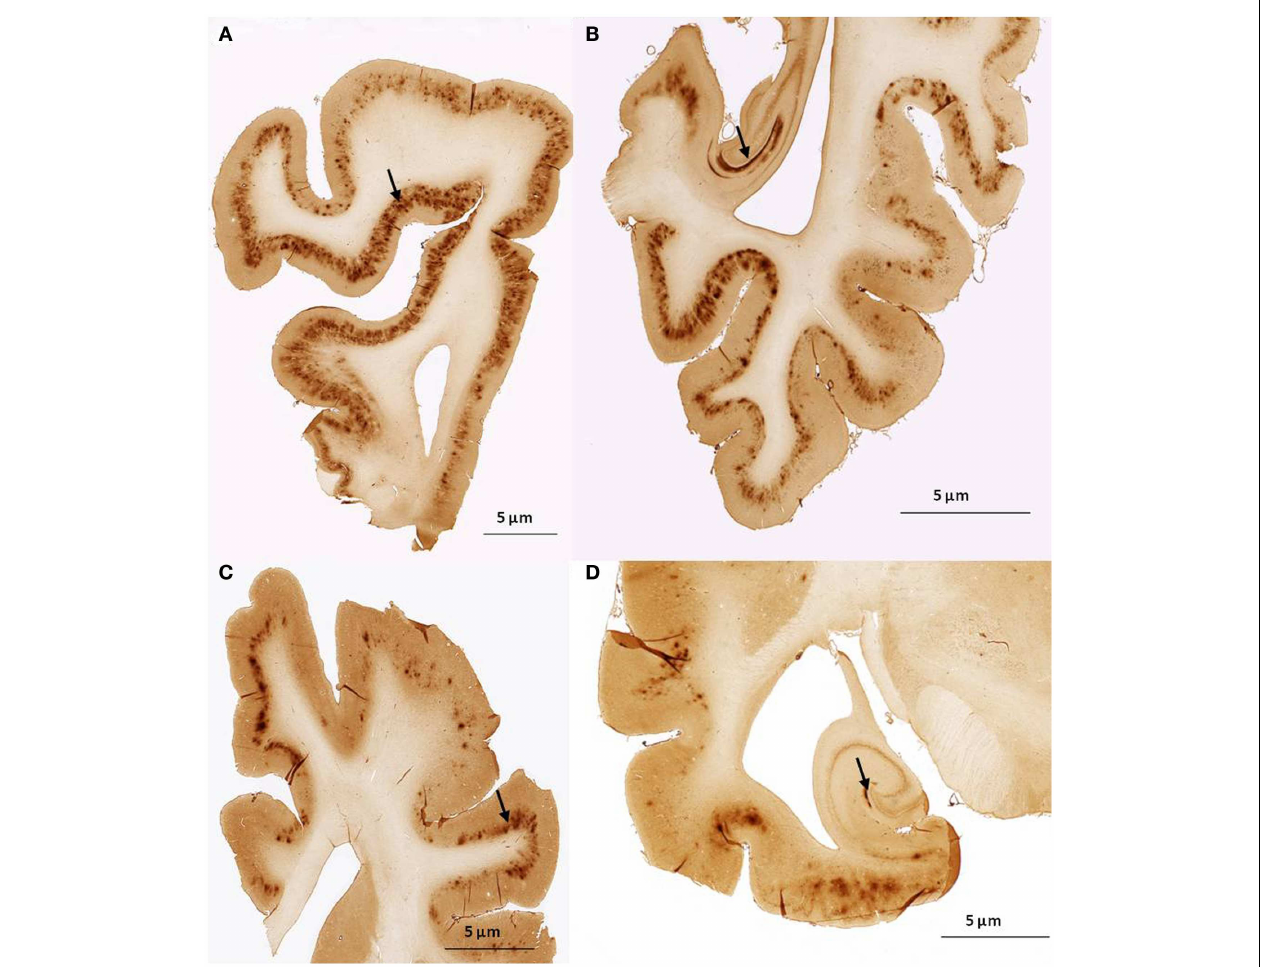
staining of the perforant pathway in the hippocampus. (C,D) are histological section from the frontal and temporal lobe, respectively. Obtained from a 13-year old collie with signs of cognitive dysfunction.The sections exhibit diffuse staining of the cortical gray matter in the frontal and temporal cortex. The perforant pathway in the hippocampus only demonstrate marked staining in a very small area compared to (B)